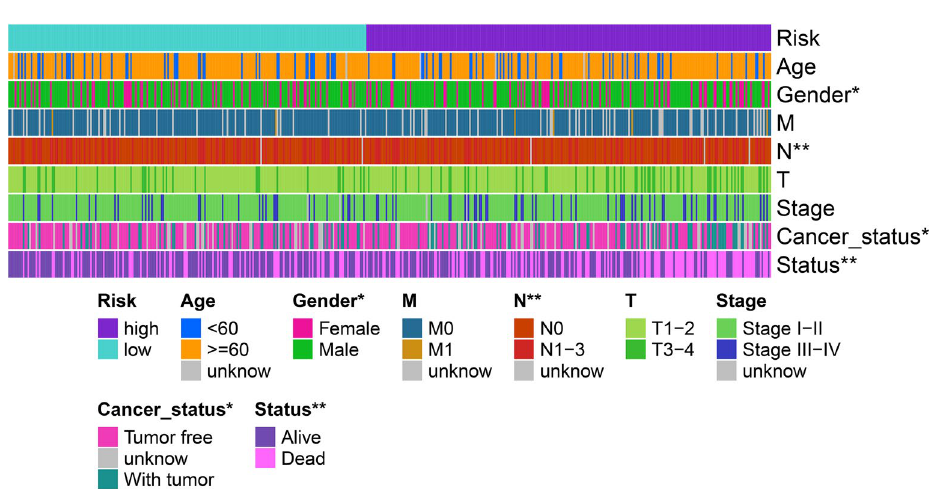
Figure 5. Relationship between the signature and clinicopathological features. *P < 0.05, **P < 0.01, ***P <